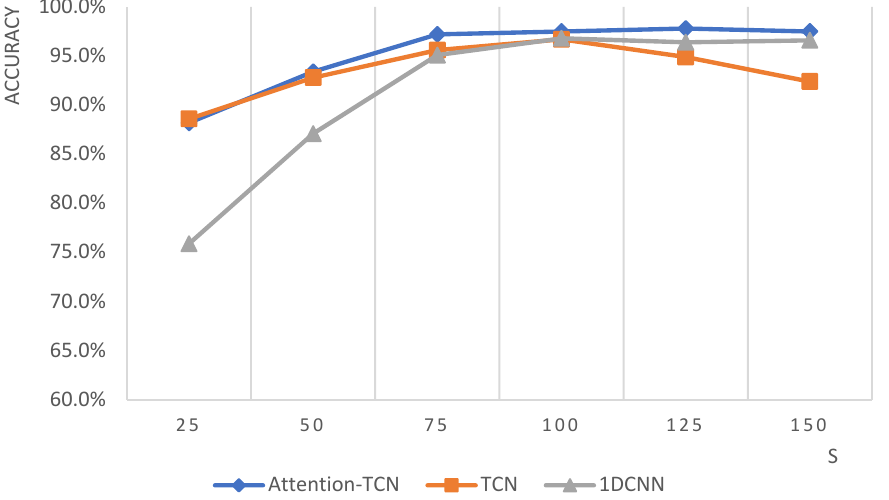
Figure 11. The accuracy of the three networks in dataset E.